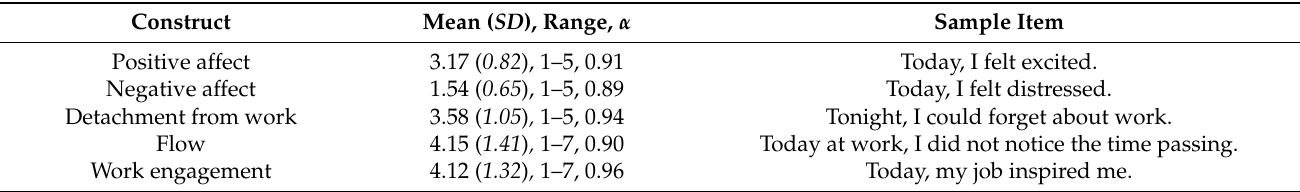
Table 3. Daily measures of well-being and motivation (Section 2.2.3).